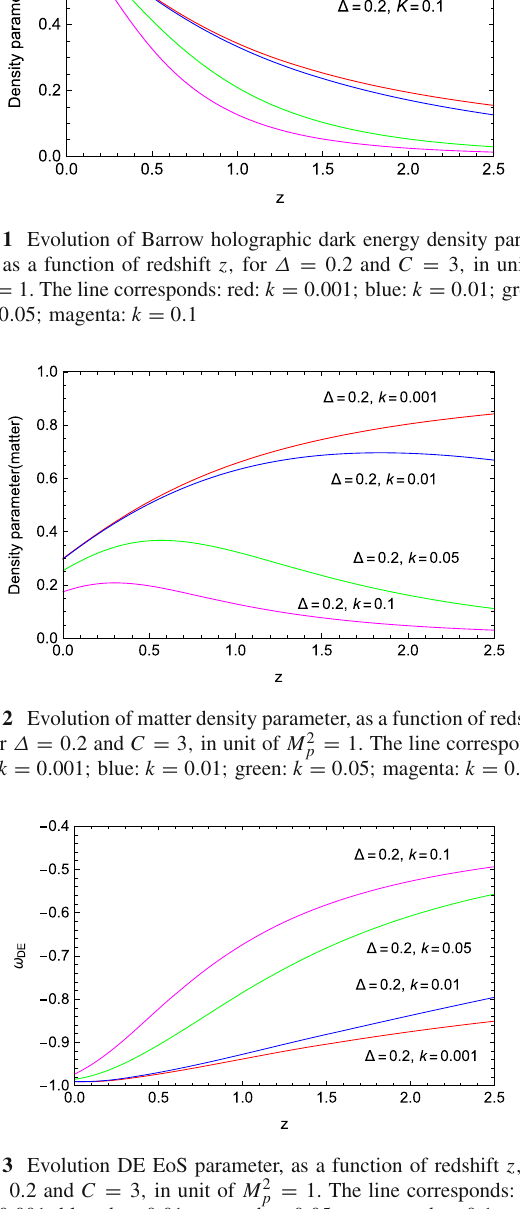
Fig. 3 Evolution DE EoS parameter, as a function of redshift z , for Δ = 0 . 2 and C = 3 , in unit of M 2 = 1. The line corresponds: red: p k = 0 . 001 ; blue: k = 0 . 01 ; green: k = 0 . 05 ; magenta: k = 0 .